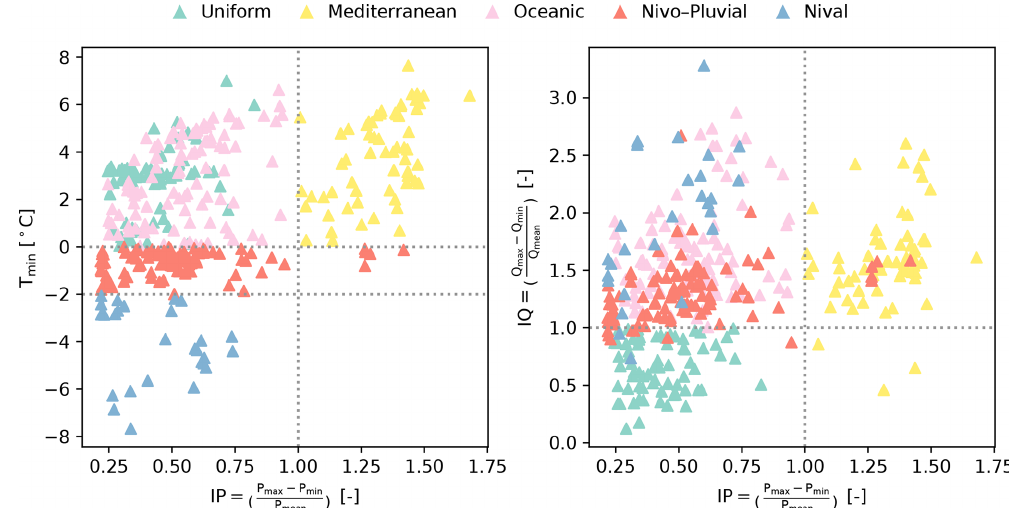
Figure 2. Classification of the catchments into five hydrologic regimes based on five conditions built on T min , IP, and IQ. In order of priority, we first evaluate two T min conditions: T min < − 2 and T min < 0. For catchments not satisfying either of these two conditions, we then check if IP > 1. If this condition is also unsatisfied, the IQ > 1 condition is evaluated. Each point represents a catchment, and its colour indicates its